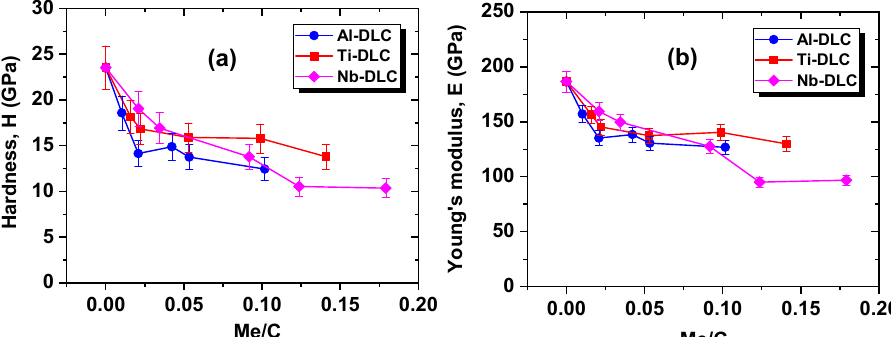
Figure 10. Evolution of ( a ) hardness and ( b ) Young’s modulus of Me-DLC coatings (Me = Al, Ti, or Nb).